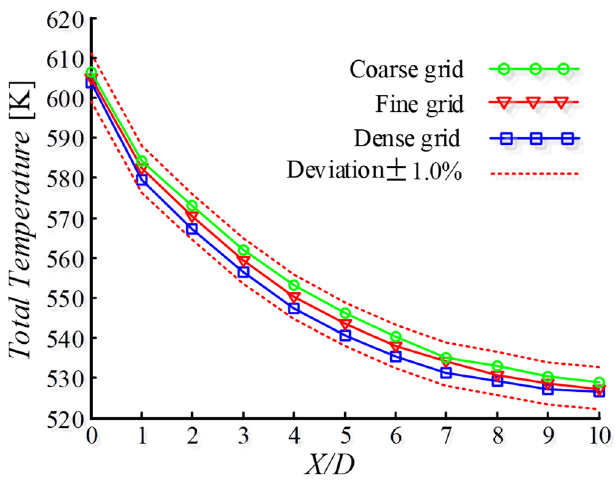
Figure 8. The comparison of different grids.